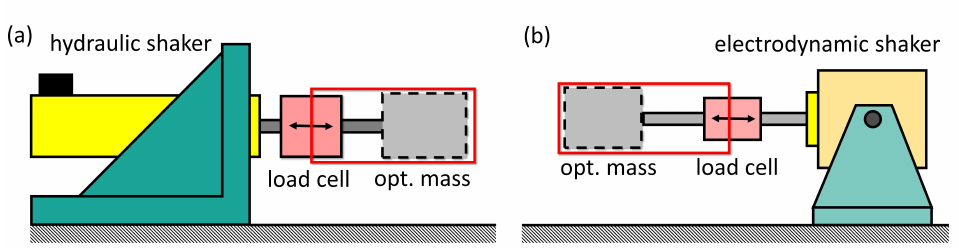
Figure 2. ( a ) Hydraulic test bench for low frequencies adapted from [32]; ( b ) electrodynamic test bench for high